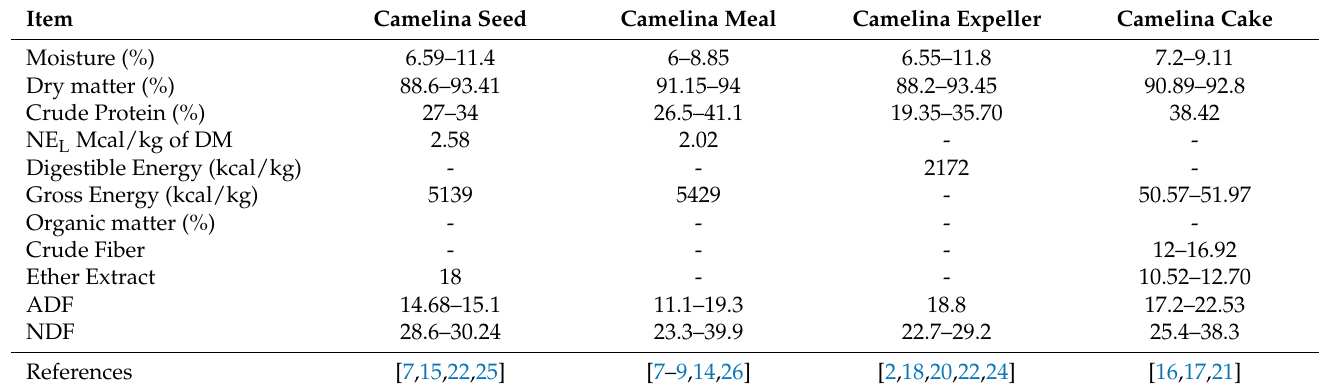
Table 1. Chemical composition of Camelina sativa seed, meal, expeller, and cake (on DM basis).